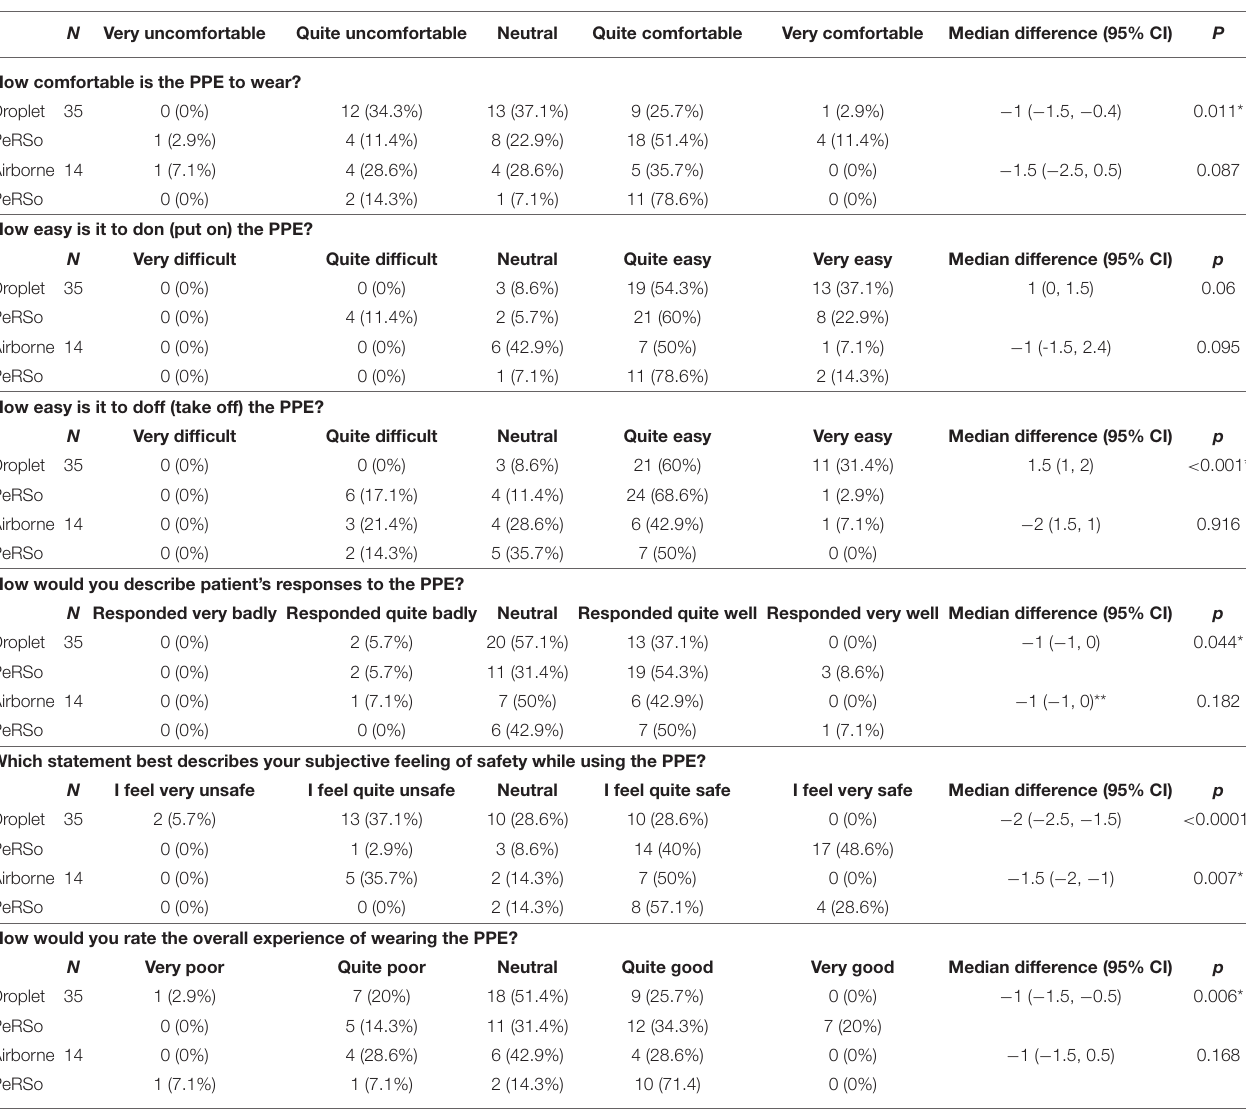
TABLE 3 | Statistical analysis of paired survey responses (Wilcoxon signed rank). N Very uncomfortable Quite uncomfortable Neutral Quite comfortable Very comfortable Median difference (95% CI)